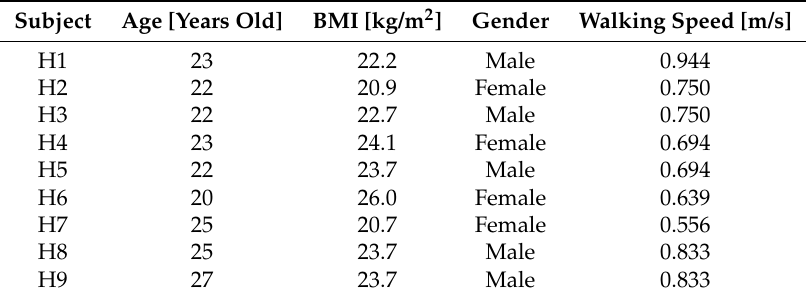
Table 1. Summary of healthy participants (H group). BMI, body mass index.